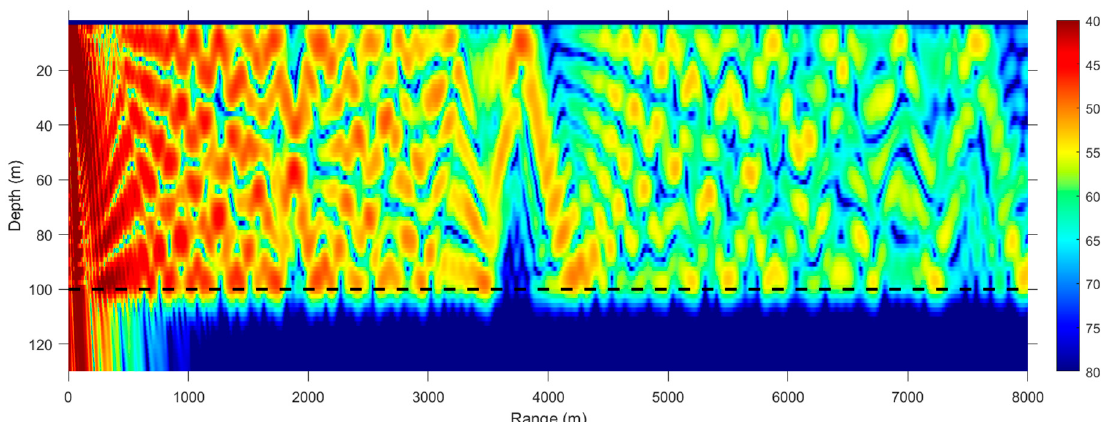
Figure 7. The TL contour in the Pekeris waveguide case using the NFD with PPW = 6 (the black dotted line shows the seabed).